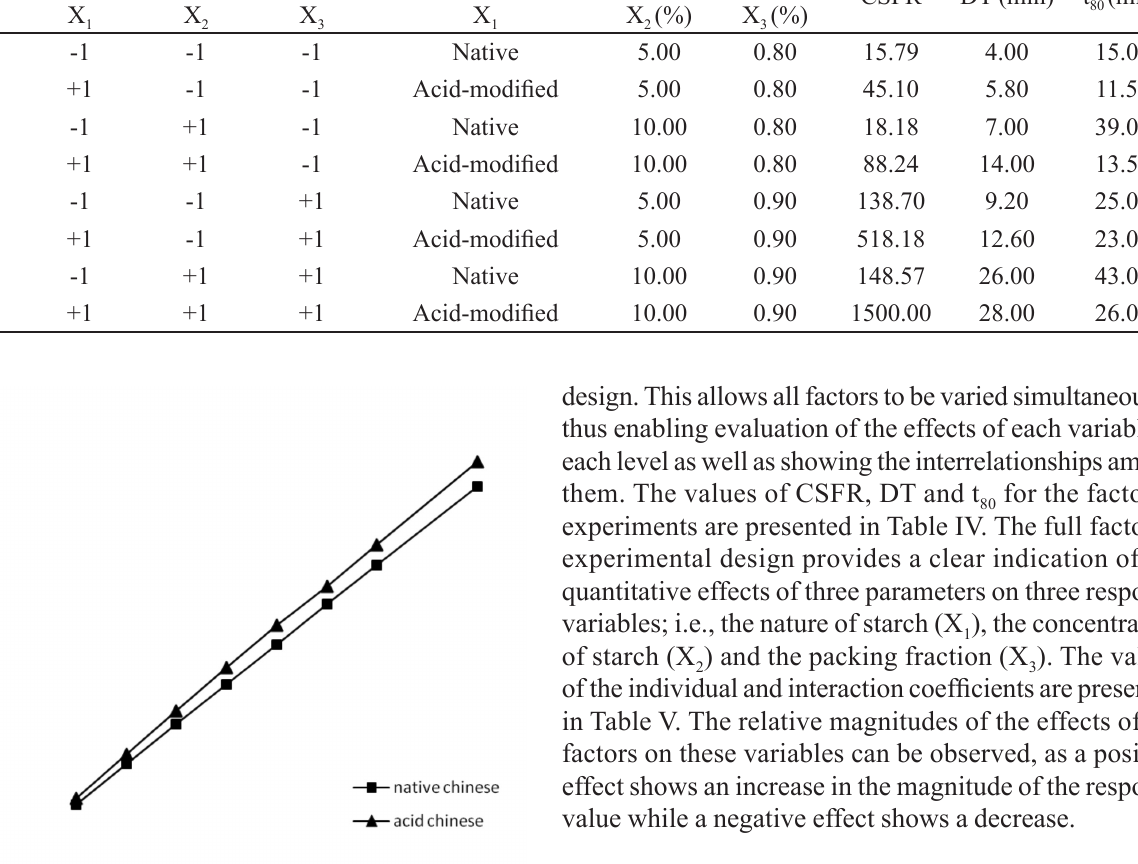
TABLE IV - Factorial design for the formulation and evaluation of batches Batch code